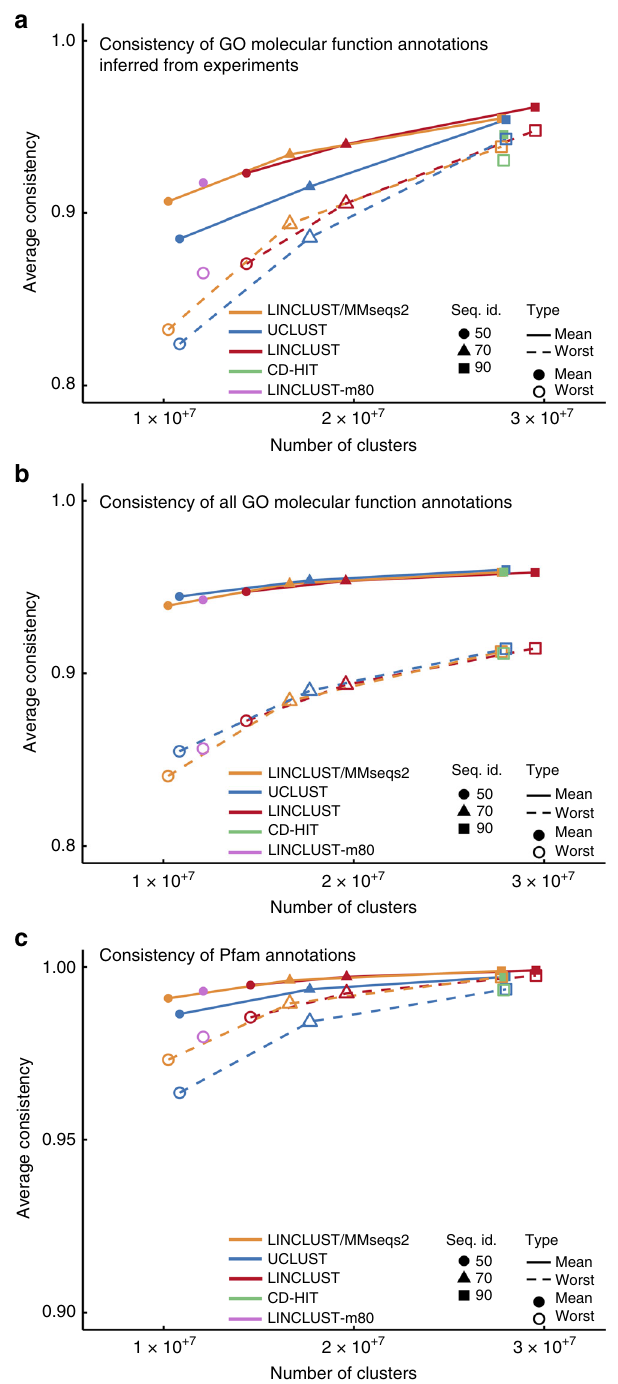
Fig. 4 Cluster consistency of GO molecular functional and Pfam annotations. a Cluster annotation consistency of GO functional annotations inferred from experiments (EXP_F). “ Mean ” and “ worst ” refers to the mean and the minimum annotation similarity between each representative sequence and all other cluster members. Plotting symbols indicate the sequence identity threshold for clustering. CD-HIT was only run at 90% sequence identity due to run time constraints. Linclust-m80 was only run at 50% sequence identity. b Same as ( a ) but using manually and computationally assigned functional GO annotations. c Consistency of Pfam annotation from the representative sequences to the cluster